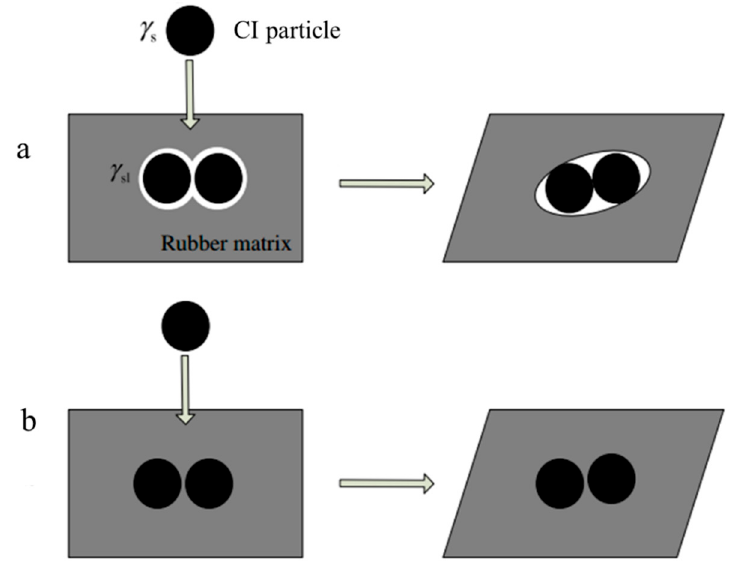
Figure 10. Relative state between the rubber matrix and CI particles before and after the application of shear stress: ( a ) MRE; ( b ) Si-MRE.